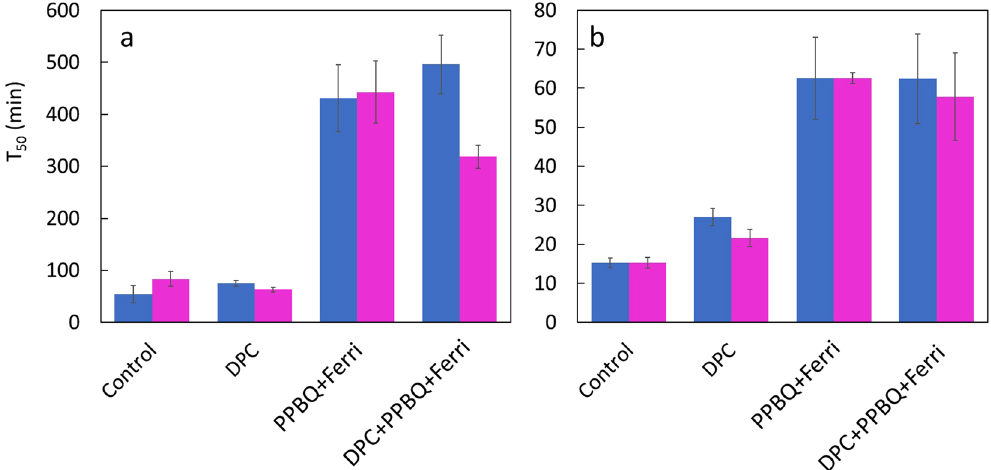
Figure 2. A comparison between T 50 of loss of F V /F M and Mn 2 + release after illumination with 460 nm and 660 nm for 2 h. The T 50 of ( a ) Mn 2 + release and ( b ) loss of F V /F M after illumination with 460 nm (blue) and 660 nm (magenta) illuminations. Average values are presented ± standard error. For fluorescence measurements n = 6 and for EPR measurements n =